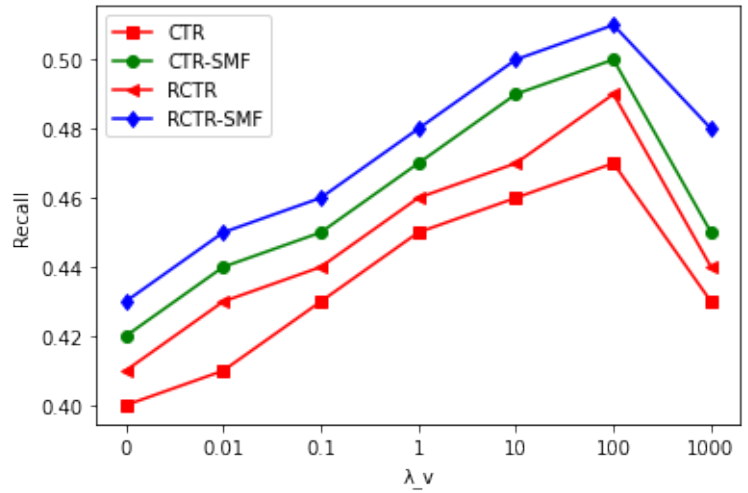
while keep- 𝜆𝜆 𝑣𝑣